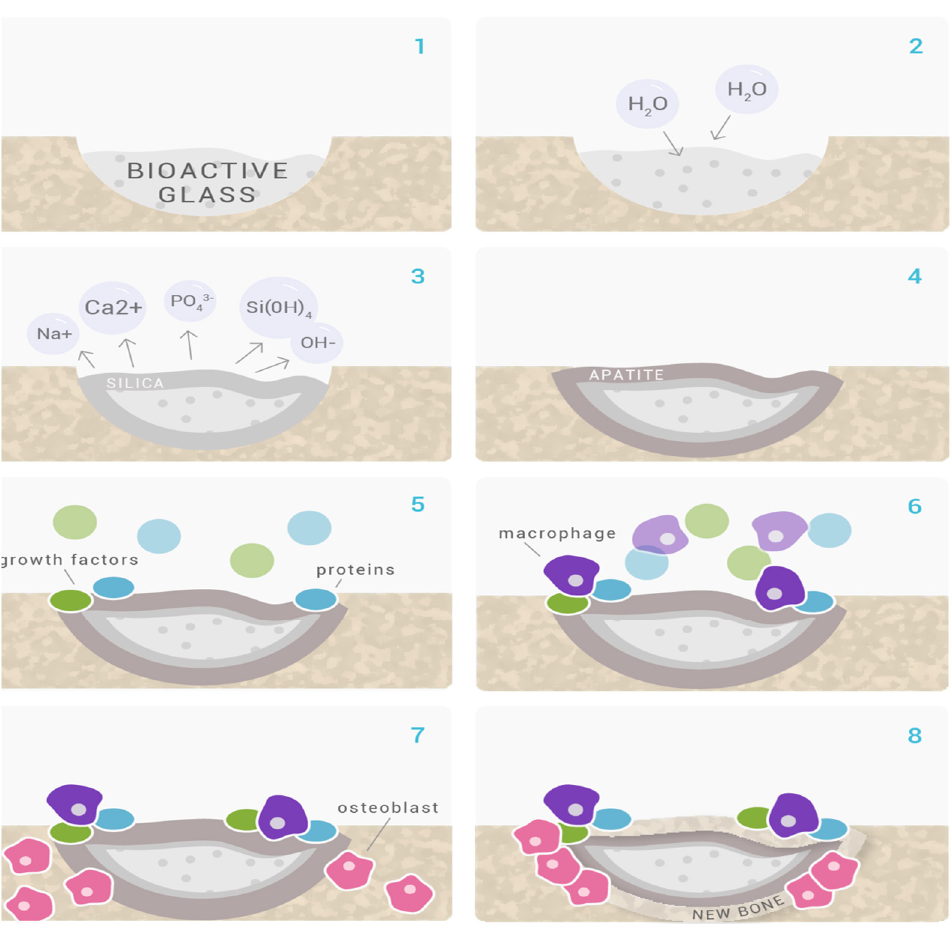
Figure 2. Mechanism of bone regeneration by BGs. ( 1 , 2 ) On the surface of the Glassbone, calcium and natrium ions quickly interact with body fluids. In addition to causing localized increases in pH and osmotic pressure, the reaction results in the hydrolysis of silica groups; ( 3 ) At the surface of Glassbone, soluble silica is converted to create a silica-gel layer; ( 4 ) A layer of carbonated hydroxyl apatite (HCA), which is a component of the mineral phase of natural bone, develops on top of Glassbone. ( 5 , 6 ) Growth factors adsorb to the surface of Glassbone due to its structural and chemical similarities to hydroxyapatite. Growth factors cause M2 macrophages to become activated, which aids in wound healing and starts progenitor cell migration to the area; ( 6 , 7 ) Mesenchymal stem cells and osteoprogenitor cells migrate to the Glassbone surface and adhere to the HCA layer as a result of M2 macrophage activation, where they undergo osteogenic cell differentiation to become osteoblasts; ( 7 , 8 ) Type I collagen, the primary protein constituent of bone, and other extracellular matrix (ECM) components are produced and deposited by the attached and developed osteoblasts; [9,10] Following these responses, the newly recruited cells continue to work and support tissue growth and repair, which results in the formation of new bone. Glassbone is still deteriorating and being changed into new ECM material [17].